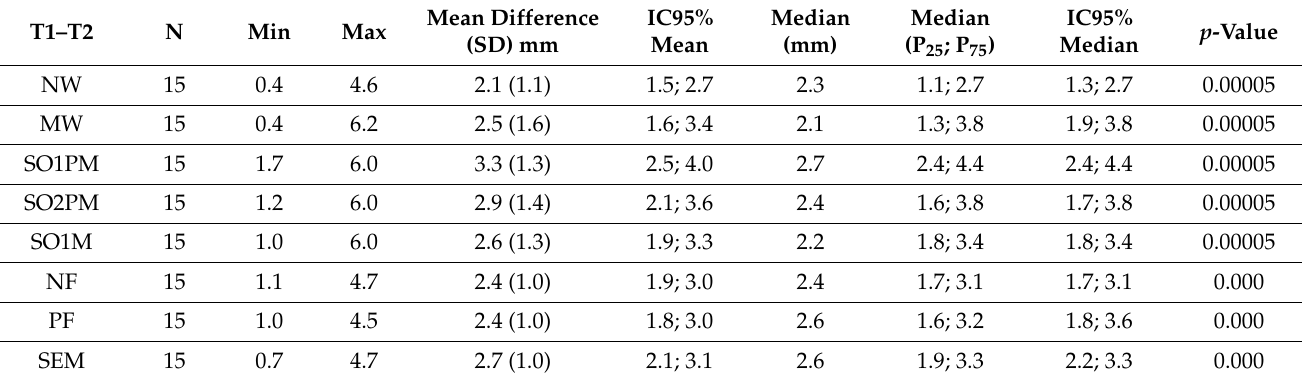
Table 6. Comparison of Pre and Posttreatment Skeletal measurements. Skeletal changes comparing